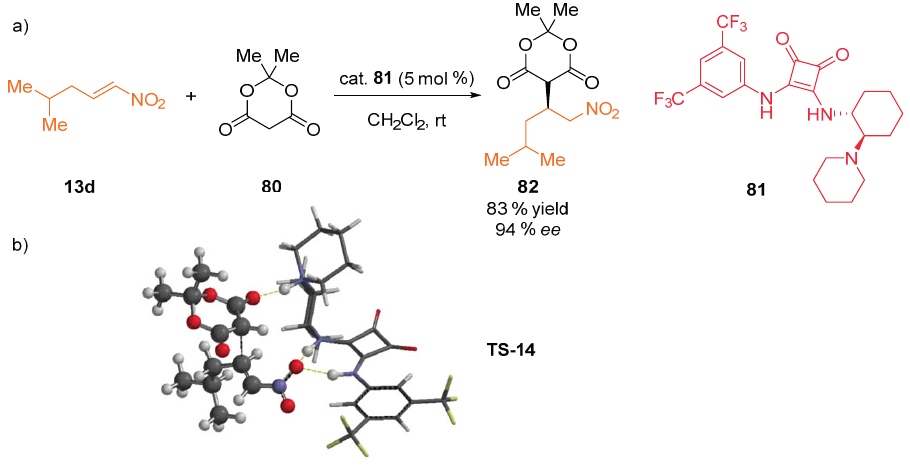
Figure 21. Michael addition of Meldrum’s acid 80 to nitroalkene 13e ( a ); proposed transition state model ( b